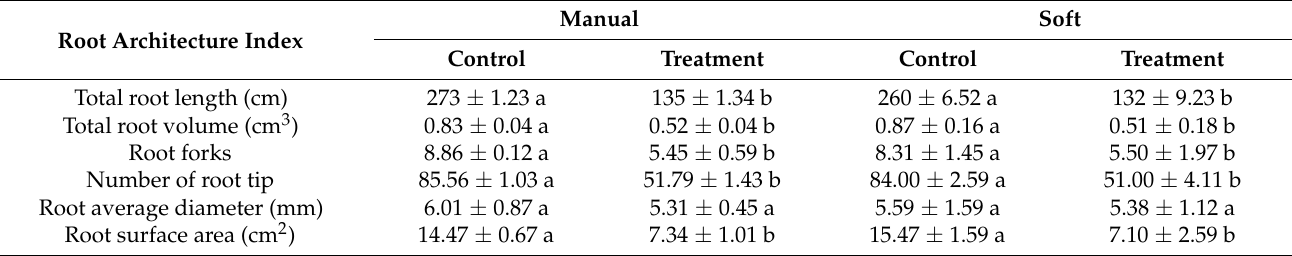
Table 1. Root architecture indices of